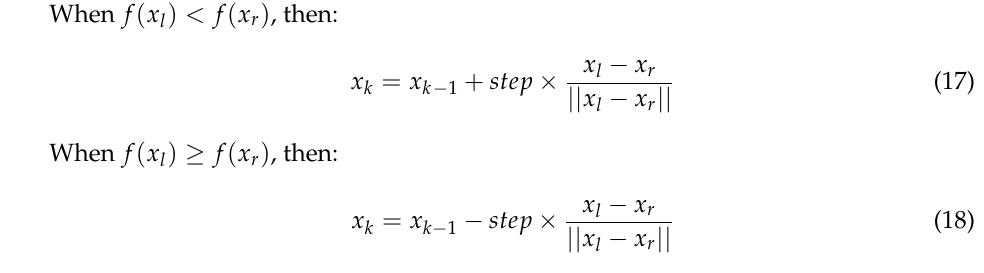
Table 1. Lathe Table 1. Lathe parameters.